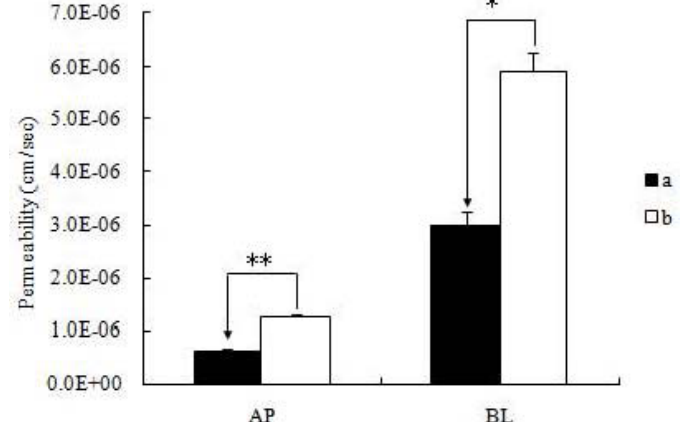
Figure 4. Permeabilities of icariin + DOC and icariin + DOC + suet oil. The experiments were performed at 37°C. Each bar represents the average of three determinations and the error bars are the standard deviation of the means. One-way ANOVA with Tamhane’s post hoc test was used to analyze the data statistically, ** p < 0.01 and * p < 0.05. ( a : 20 μ M icariin + DOC; b : 20 μ M icariin + DOC + suet